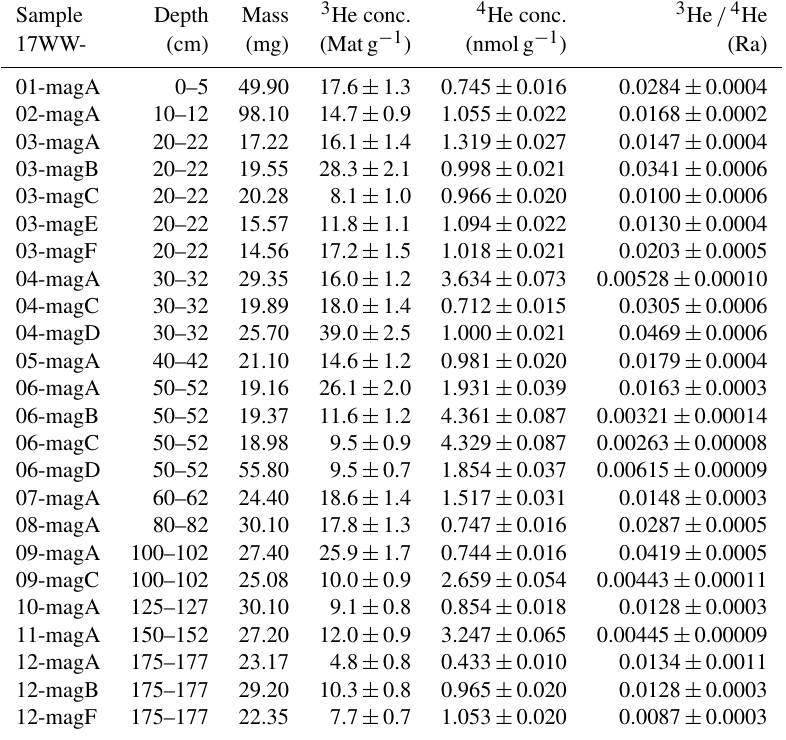
Table 2. Measurements of 3 He and 4 He concentrations in bulk magnetite aliquots, which were not scanned using microCT. They likely contain many grains with inclusions.